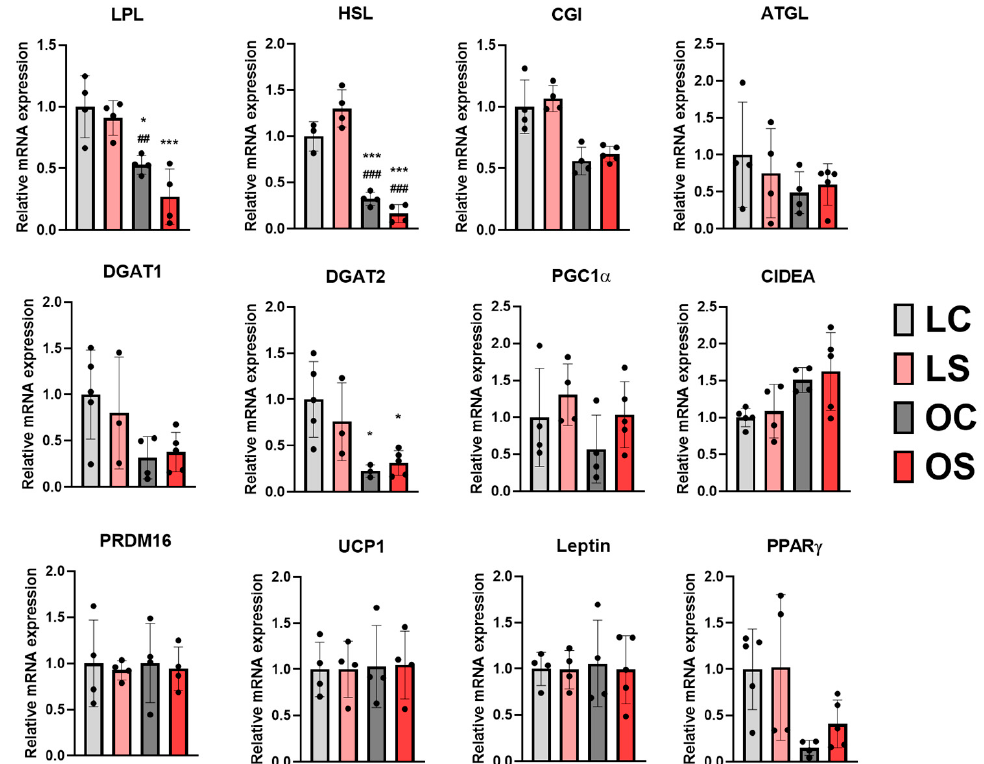
Figure 6. Gene expression lipid metabolism and mitochondrial function in epididymal adipose tissue. LC, lean control; LS, lean supplemented with sofrito ; OC, obese control; OS, obese supplemented with sofrito . * p < 0.05, *** p < 0.001 vs. LC; ## p < 0.01, ### p < 0.001 vs. LS. ATGL, adipose triglyceride lipase; CGI, comparative gene identification 58 ( α / β hydrolase); CIDEA, cell death activator; DGAT1, diacylglycerol O-acyltransferase 1; DGAT2, diacylglycerol O-acyltransferase 2; HSL, hormone-sensitive lipase; LPL, lipoprotein lipase; PRDM16, PR domain-containing 16, PGC1 α , peroxisome proliferator-activated receptor gamma coactivator 1-alpha, PPAR γ , peroxisome proliferator-activated receptor gamma; UCP1, uncoupling protein 1.